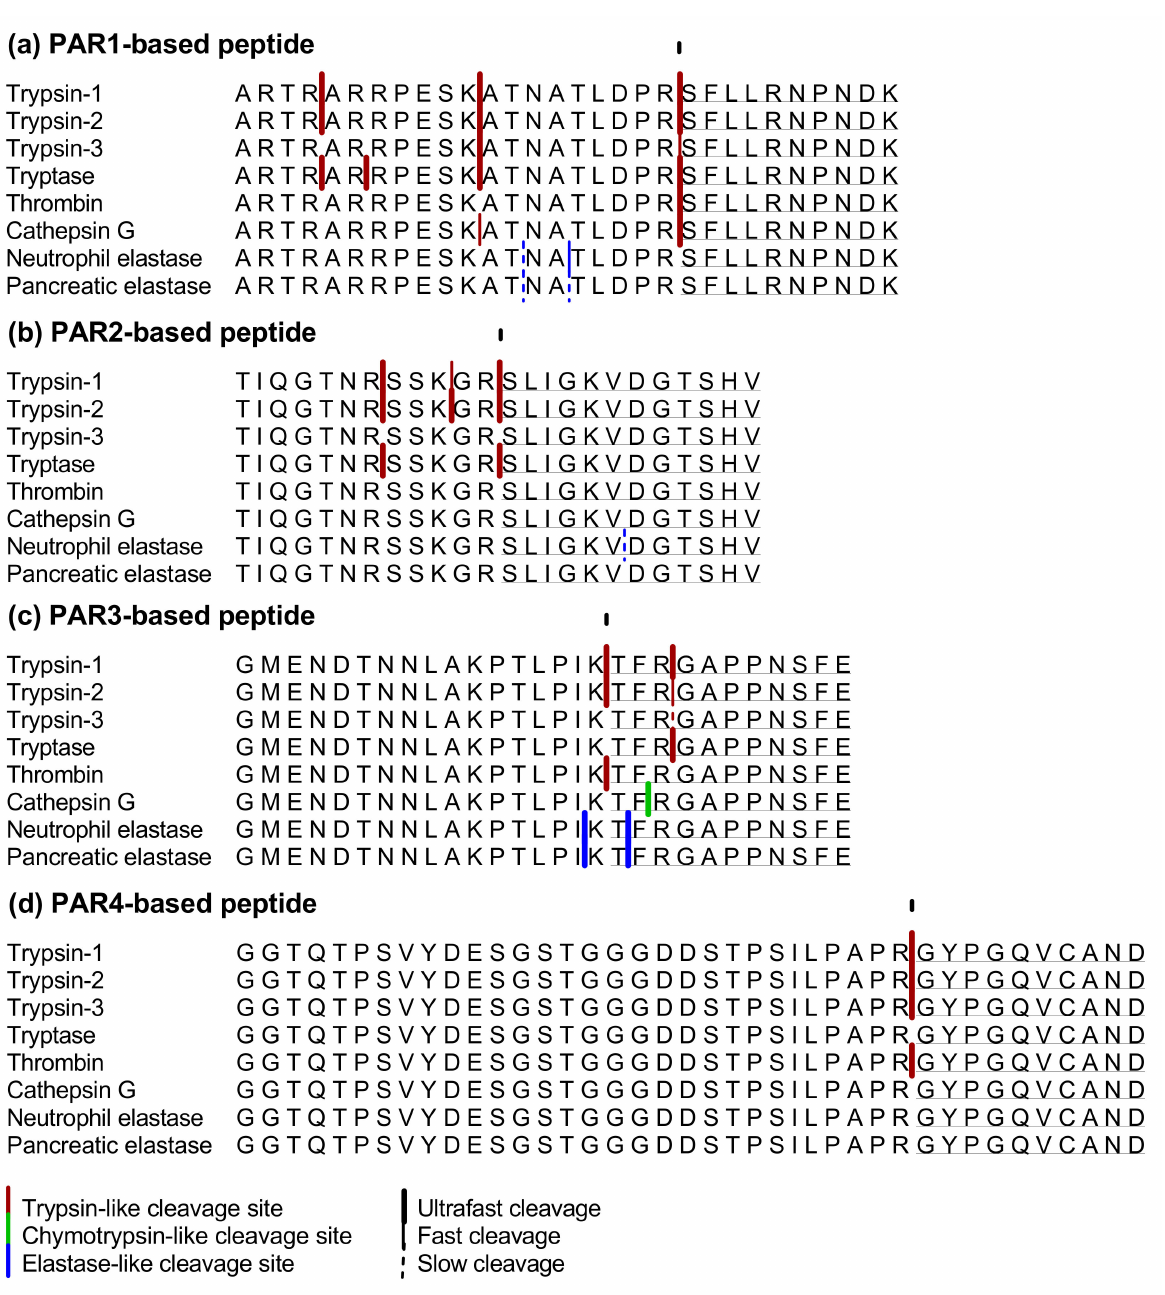
Figure 2. Cleavage sites in the ( a ) PAR1-, ( b ) PAR2-, ( c )PAR3- and ( d ) PAR4-based peptides after incubation with trypsin-1, trypsin-2, trypsin-3, tryptase, thrombin, cathepsin G, neutrophil elastase or pancreatic elastase. Trypsin-like cleavage sites are shown in red, chymotrypsin-like cleavage sites in green and elastase-like cleavage sites in blue. Thick lines indicate ultrafast cleavages (within two min of incubation), thin lines indicate fast cleavages (after 5 min of incubation) and dotted lines indicate slow cleavages (after 10 or 30 min of incubation). The arrow indicates the cleavage site for the unmasking of the TL-sequence (underlined). The cleavages in the TL-sequence cause disarming of the PAR-based